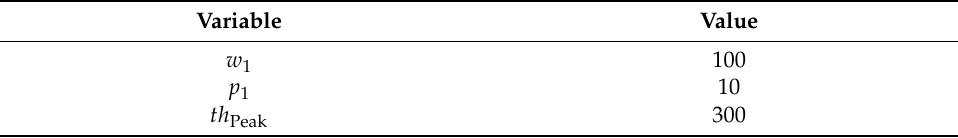
Table 4. Values assumed for hybrid-DRL reward function